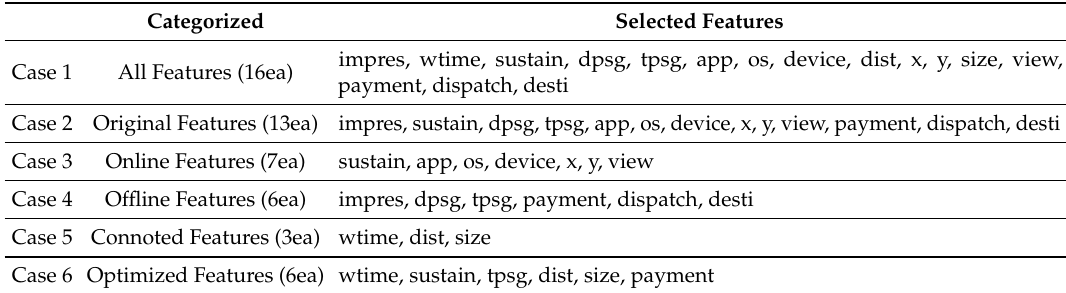
Table 5. Categorization of features by